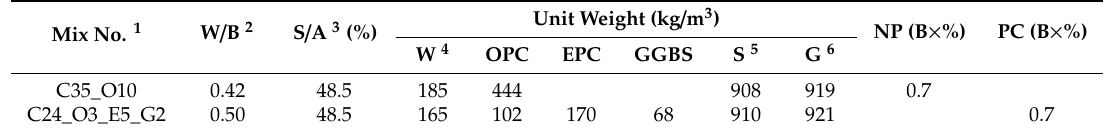
Table 4. Mixing proportions of concrete.